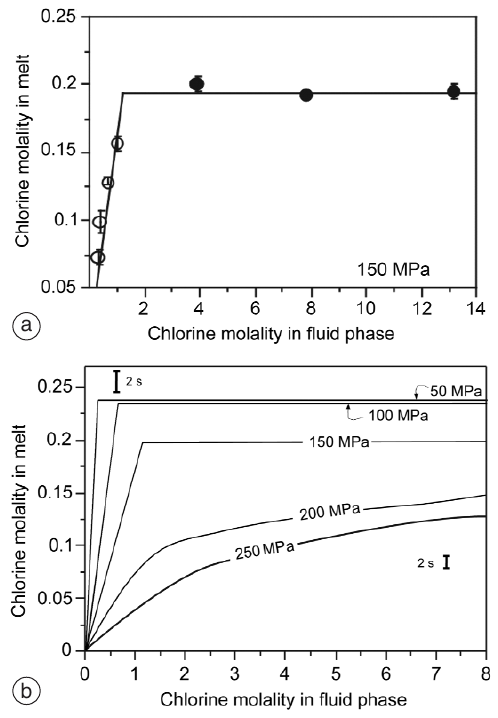
Fig. 2a,b. Variation of the chlorine molality in the melt with the calculated chlorine molality in a single fluid phase (for brine-saturated conditions this is an «apparent molality» because the melt coexists with both Cl-poor aqueous fluid and Cl-rich brine). a) Chlorine molality (C m,Cl ) of MB phonolitic melts ver- sus Cl molality at P = 150 Mpa, T = 850°C. Experi- ments carried out in the two-phase field (melt + aque- ous fluid) are represented as open circles and those in the three-phase field (melt + aqueous fluid + hydros- aline brine) are represented as solid circles. b) Sum- mary of variation of the chlorine molality in the melt with the chlorine molality in a single fluid phase (ex- perimental data points not shown). The vertical bars show the two-sigma standard deviations on analyses of chlorine in the silicate melt C m,Cl (moles/kg) C m,Cl (ppm)/35450 (data from Signorelli and Carroll,